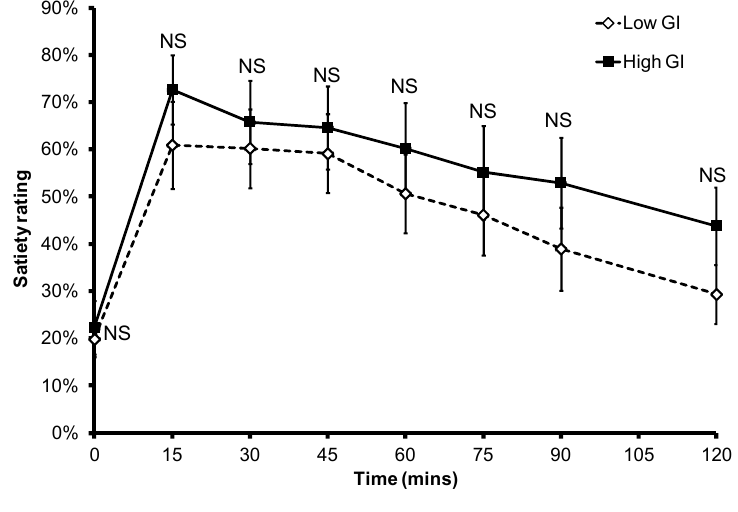
Figure 3. Subjective satiety after a low or high GI breakfast. NS: